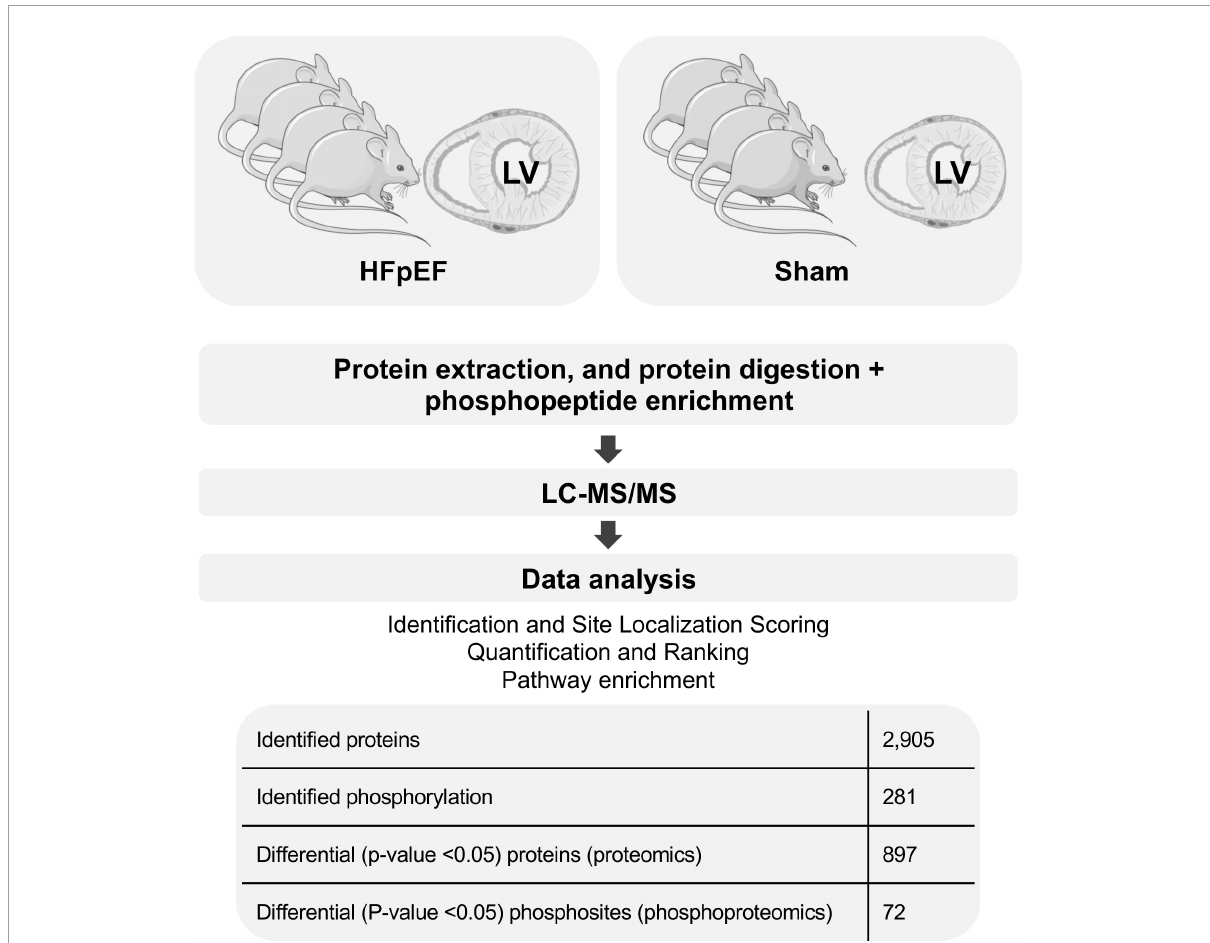
FIGURE1 General proteomics and phosphoproteomics workflow. The figure was partly generated using Servier Medical Art, provided by Servier, licensed under a Creative Commons Attribution 3.0 unported